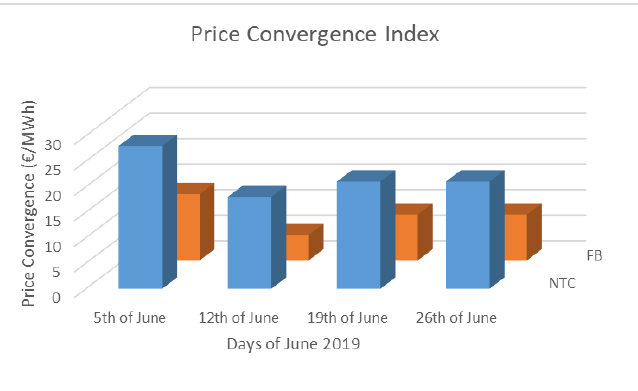
Figure 6. Price convergence index for the five-country scenario via both approaches.